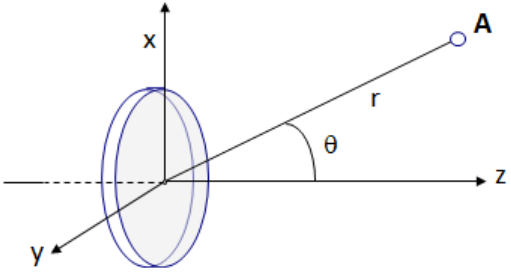
Figure 2. Point for analysis of the pressure outside the normal axis in polar